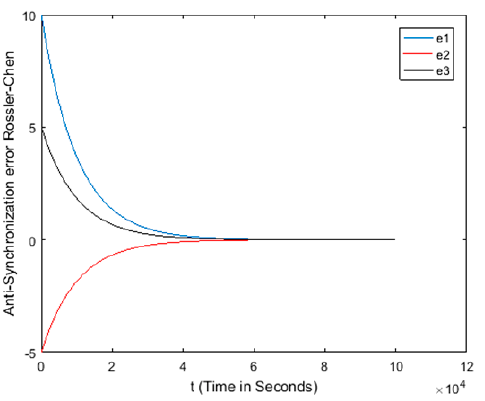
Figure 9. Phase space of anti-synchronization of master–slave systems with fractional orders given by c = 0.9, c1 = 0.8, and c2 = 0.7.